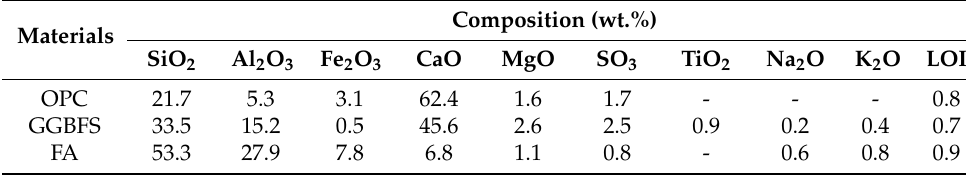
Table 4. Chemical properties of OPC, FA, and GGBFS.